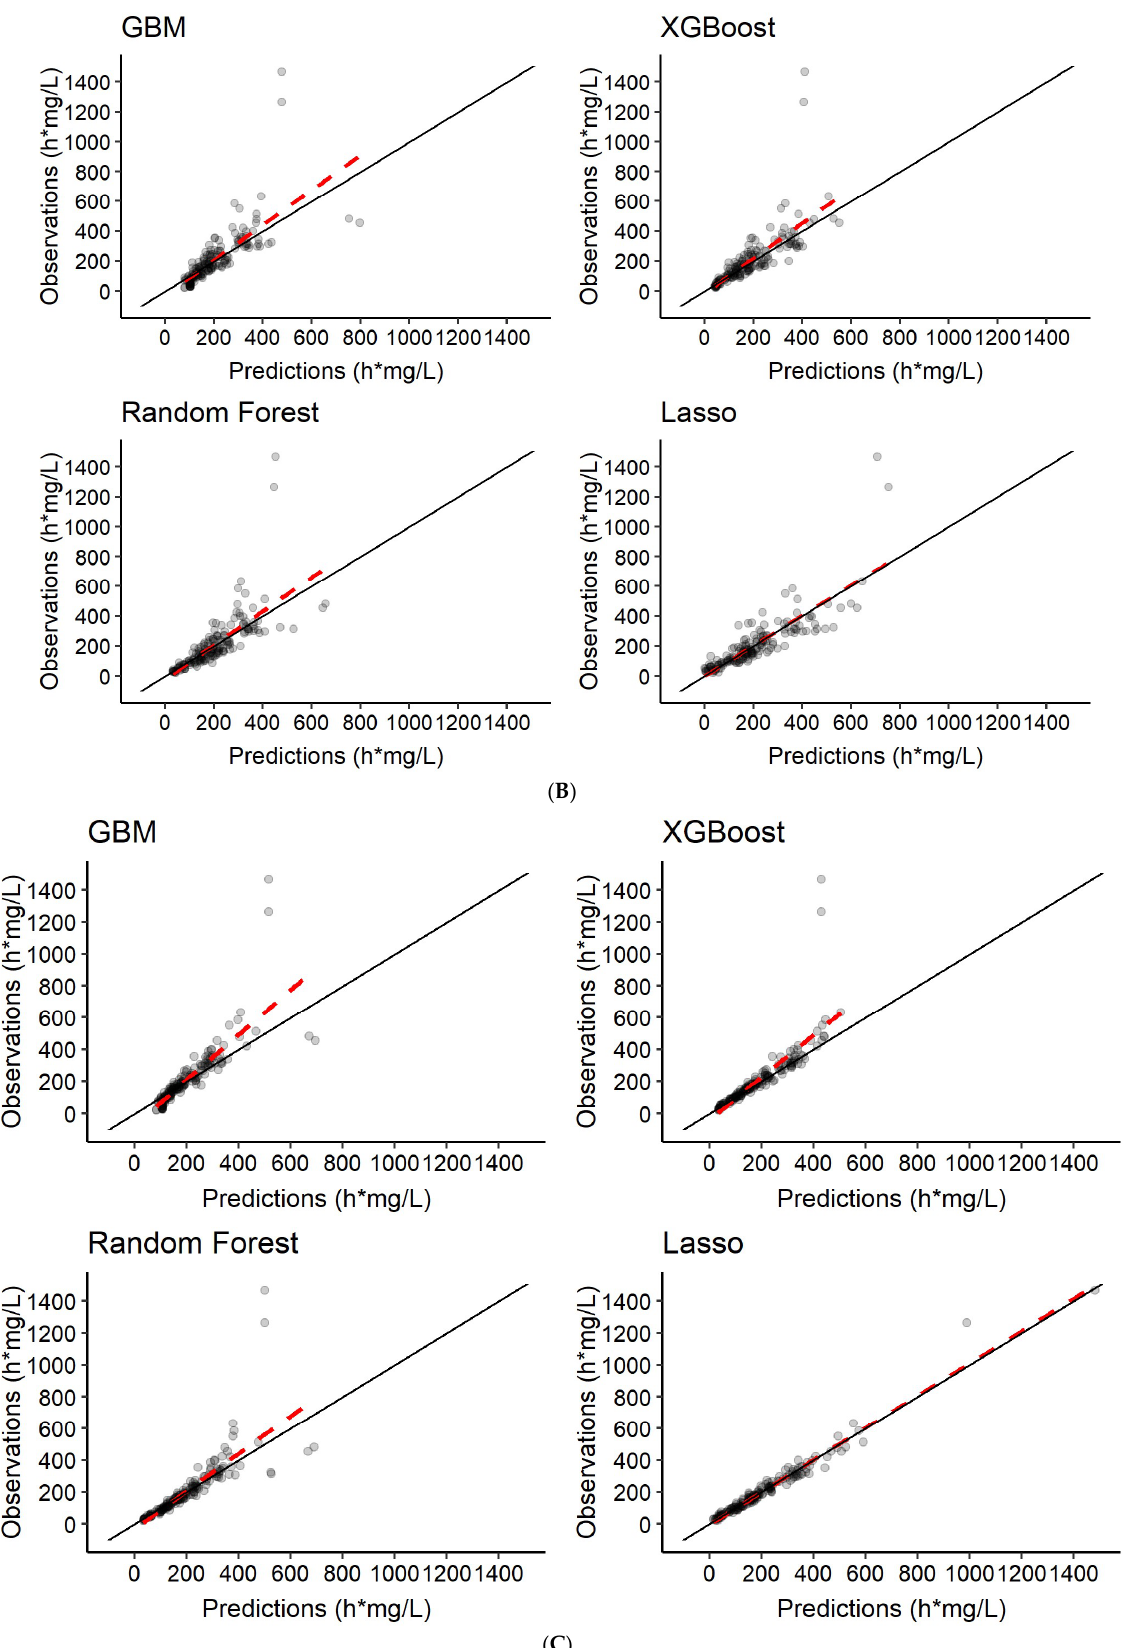
Figure 9. Predictions of rifampicin AUC 0–24h at days 7 and 14 from the different ML algorithms com- pared to the NCA derived AUC 0–24h , considered to be observations in this study. Panel ( A ) is the scenario where the model was trained using features only as input. In panel ( B ), the models were trained to predict rifampicin AUC 0–24h based on features and 2 plasma concentrations at time-points 2 h and 4 h post-dose at days 7 and 14. In panel ( C ), the models were trained to predict rifampicin AUC 0–24h based on features and 6 plasma concentrations at time-points 0.5 h, 1 h, 2 h, 4 h, 8 h and 24 h post-dose at days 7 and 14. The red dashed line represents a trendline through the data. The black solid line is the line of identity, indicating 100% agreement between true and predicted values. 4. Discussion When comparing PM and ML methodology in drug development in terms of physi- ological plausibility and clinical relevance, the difference that probably stands out the most is that PKPD models are based on statistical models as well as underlying biological mechanisms where the models can vary from compartmental models to full mechanistic as in physiology-based pharmacokinetic models, while ML is often a purely data-driven approach, though not in all cases. In PM, the parameters are directly biologically inter- pretable, which can aid in identifying underlying mechanisms. ML parameters, however, are mathematically interpretable albeit to a lesser extent from a biological perspective. There are, however, some artificial intelligence (AI) methodologies, such as causal AI, that provide a better interpretability. In PM, the previous mechanistic knowledge that is used as input can also introduce a bias into the analysis if imputed inappropriately, which is avoided in ML. On the other hand, the previous knowledge used in PM models is crucial for analysis of sparse datasets. There are also differences in the model-building process. When already-available ML models are used, the modeller is less involved in the model